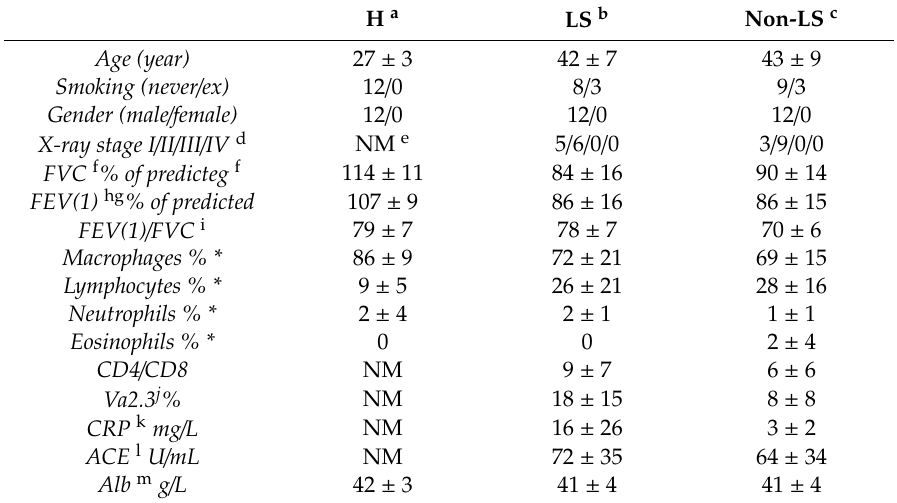
Table 2. Patient characteristics and available clinical data. Note that compared to the SpotLight data which indicated an elevation of neutrophil-mediated proteins in sarcoidosis, the relative distribution (%) of neutrophils is lower in the patients. This can be explained by a greater increase of the other cell types which would result in a relative decrease in neutrophils (even though the absolute levels are increasing). H